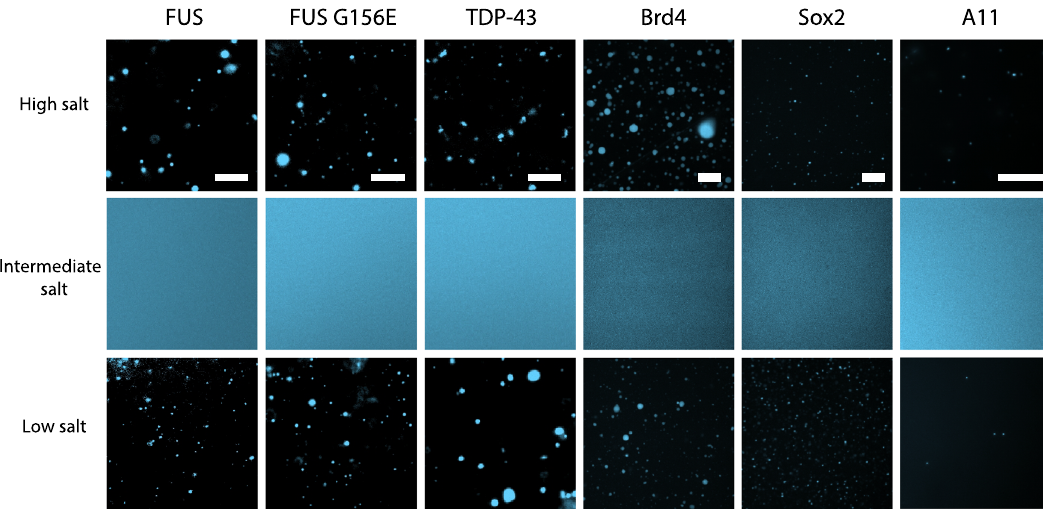
Fig. 2 Salt-mediated reentrant phase separation of FUS, FUS G156E, TDP-43, Brd4, Sox2, and A11. Representative images of FUS, FUS G156E, TDP-43 at 50 mM (low salt), 500 mM (intermediate salt), and 2.7 M KCl (high salt) in 50 mM Tris-HCl (pH 7.2); Brd4 and Sox2 at 50 mM (low salt), 500 mM (intermediate salt), and 2.15 M KCl (high salt); Brd4 buffer: 5 mM Tris (pH 7.5), 0.2 mM EDTA, 0.5% glycerol; Sox2 buffer: 5 mM Bis-Tris-Propane (pH 7.5), 0.5% glycerol; and A11 at 22.5 mM (low salt), 225 mM (intermediate salt), and 500 mM NaCl (high salt) in 20 mM HEPES (pH 7.0). For fl uorescence imaging, both FUS variants and TDP-43 were tagged with EGFP and studied at a protein concentration of 6 μ M; Brd4 and Sox2 were tagged with monoGFP and studied at protein concentrations of 6 µ M and 12.4 µ M, respectively; A11 was labeled with AlexaFluor647 and studied at a protein concentration of 15 μ M. Scale bars are 20 µ m in all images. Each data image (center panel) is representative of the observed behavior from at least three test replicates of the respective protein/salt